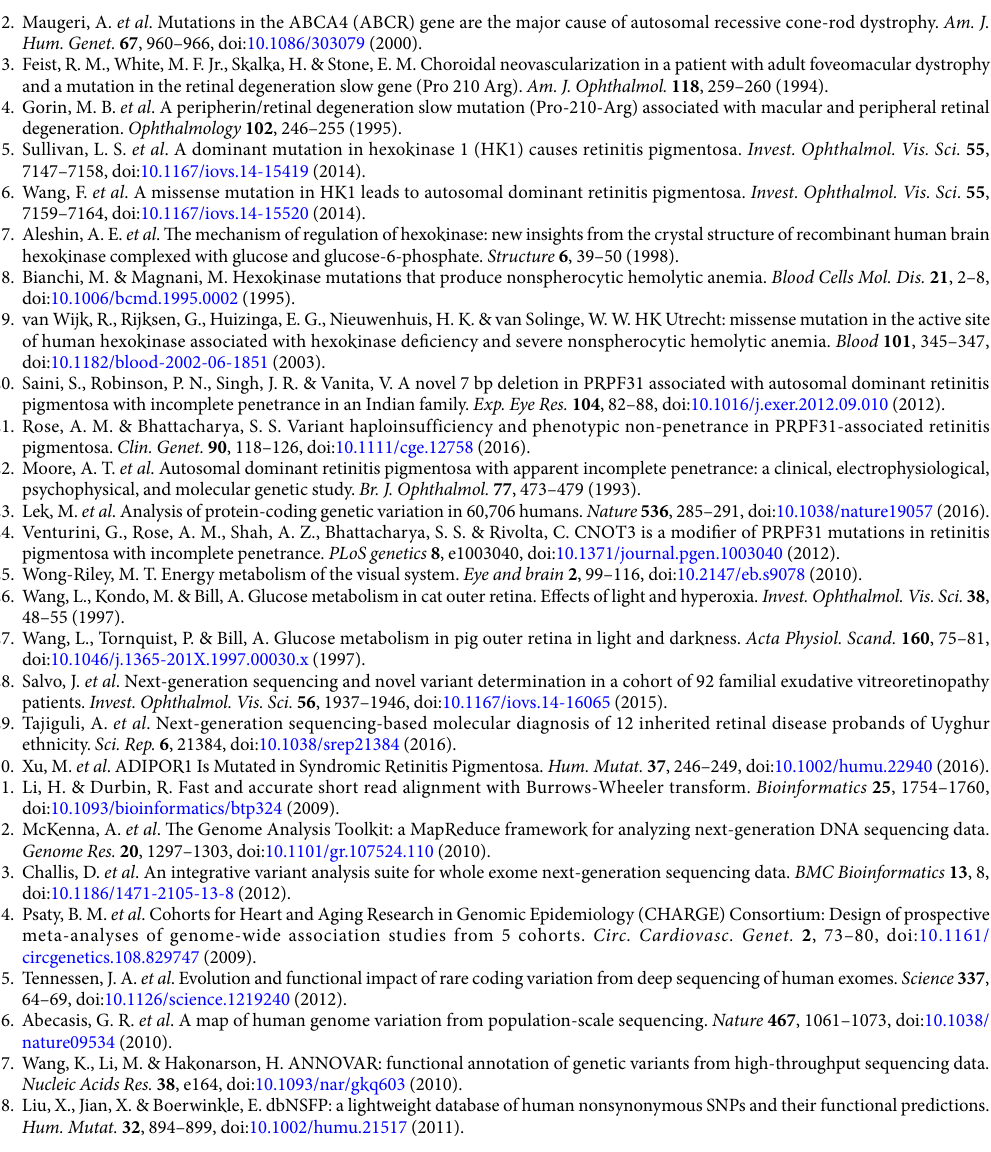
Figure 1. Z.Y., E.Y.C., and R.S. prepared Figure 2. Z.Y., B.L. and M.X. wrote the manuscript. All authors reviewed and revised the manuscript. Additional